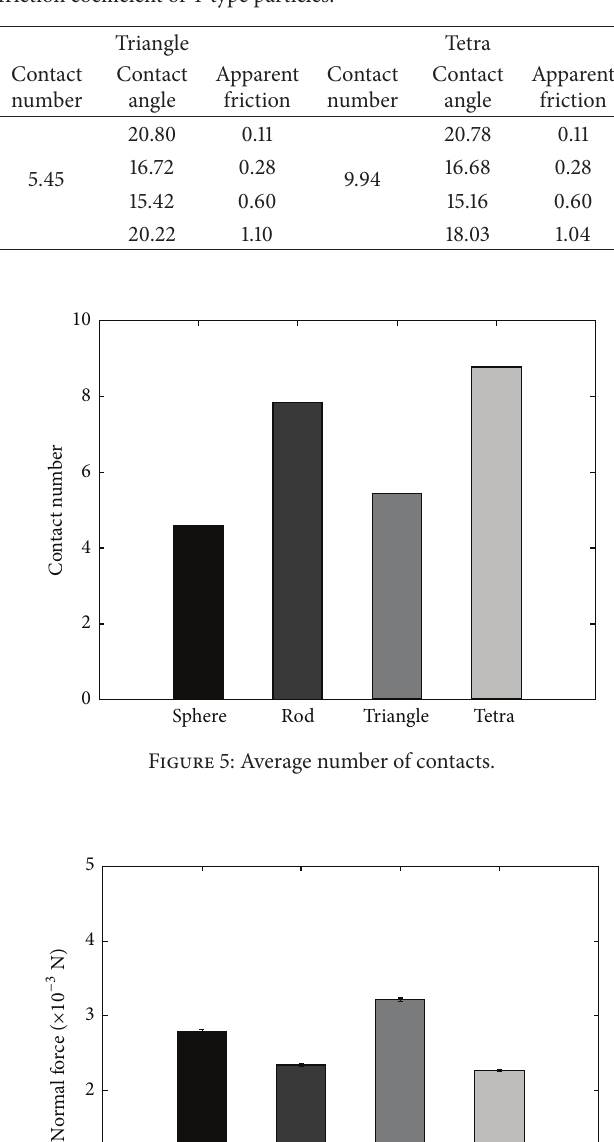
Table 2: Contact angle and apparent friction coefficient of 4-type particles.